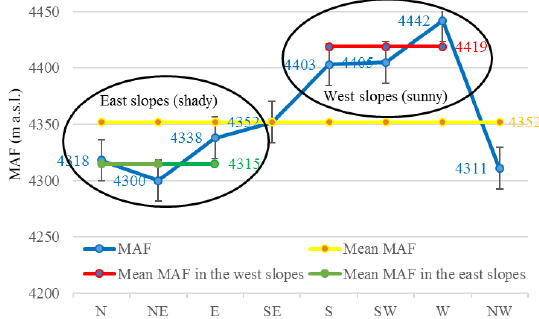
Figure 7. Minimum altitudinal rock glacier fronts (MAF) for all eight aspects, along with the overall mean. These values are taken to represent the lower boundaries of the potential permafrost extent in the Daxue Shan region (bars indicate standard errors of the mean). Daxue Shan lies along an approximately NW–SE axis; therefore we used this as the boundary separating east-facing (i.e. N, NE, E) shady slopes from west-facing (i.e. S, SW, W) sunny